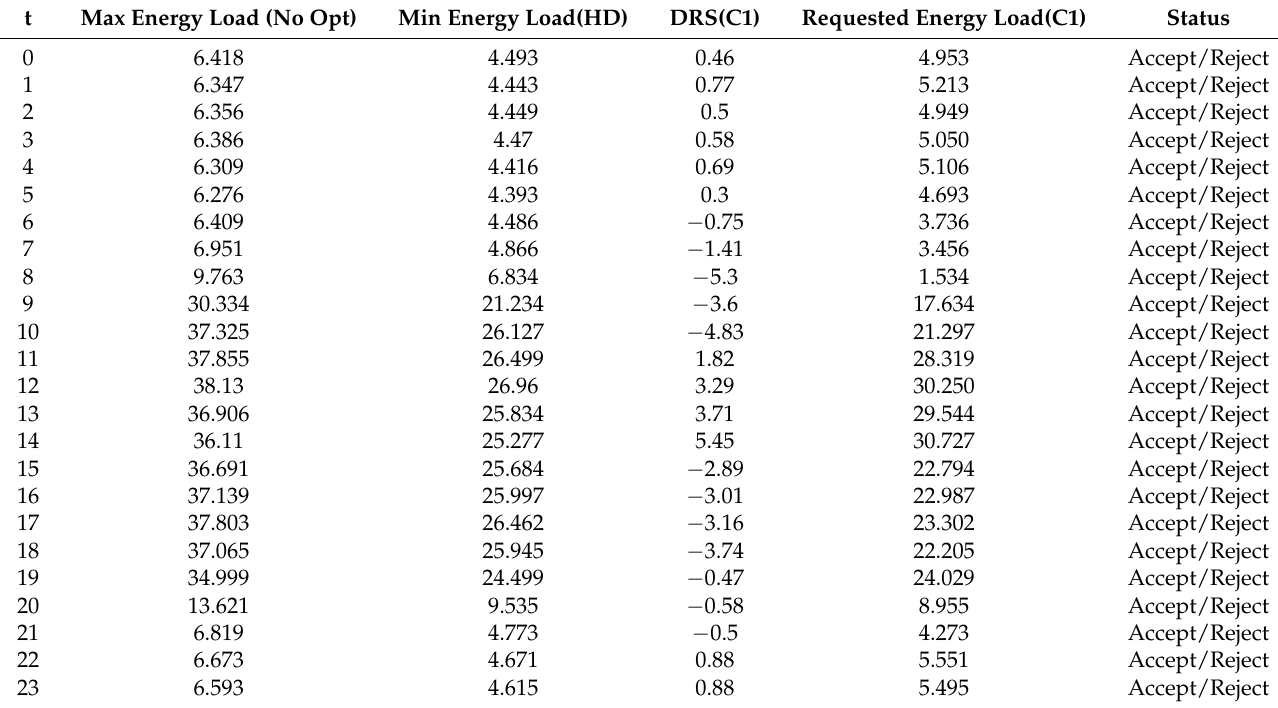
Table 5. Envisioned DR scheme and interaction between consumer and aggregator. Heavy Discomfort (HD) for